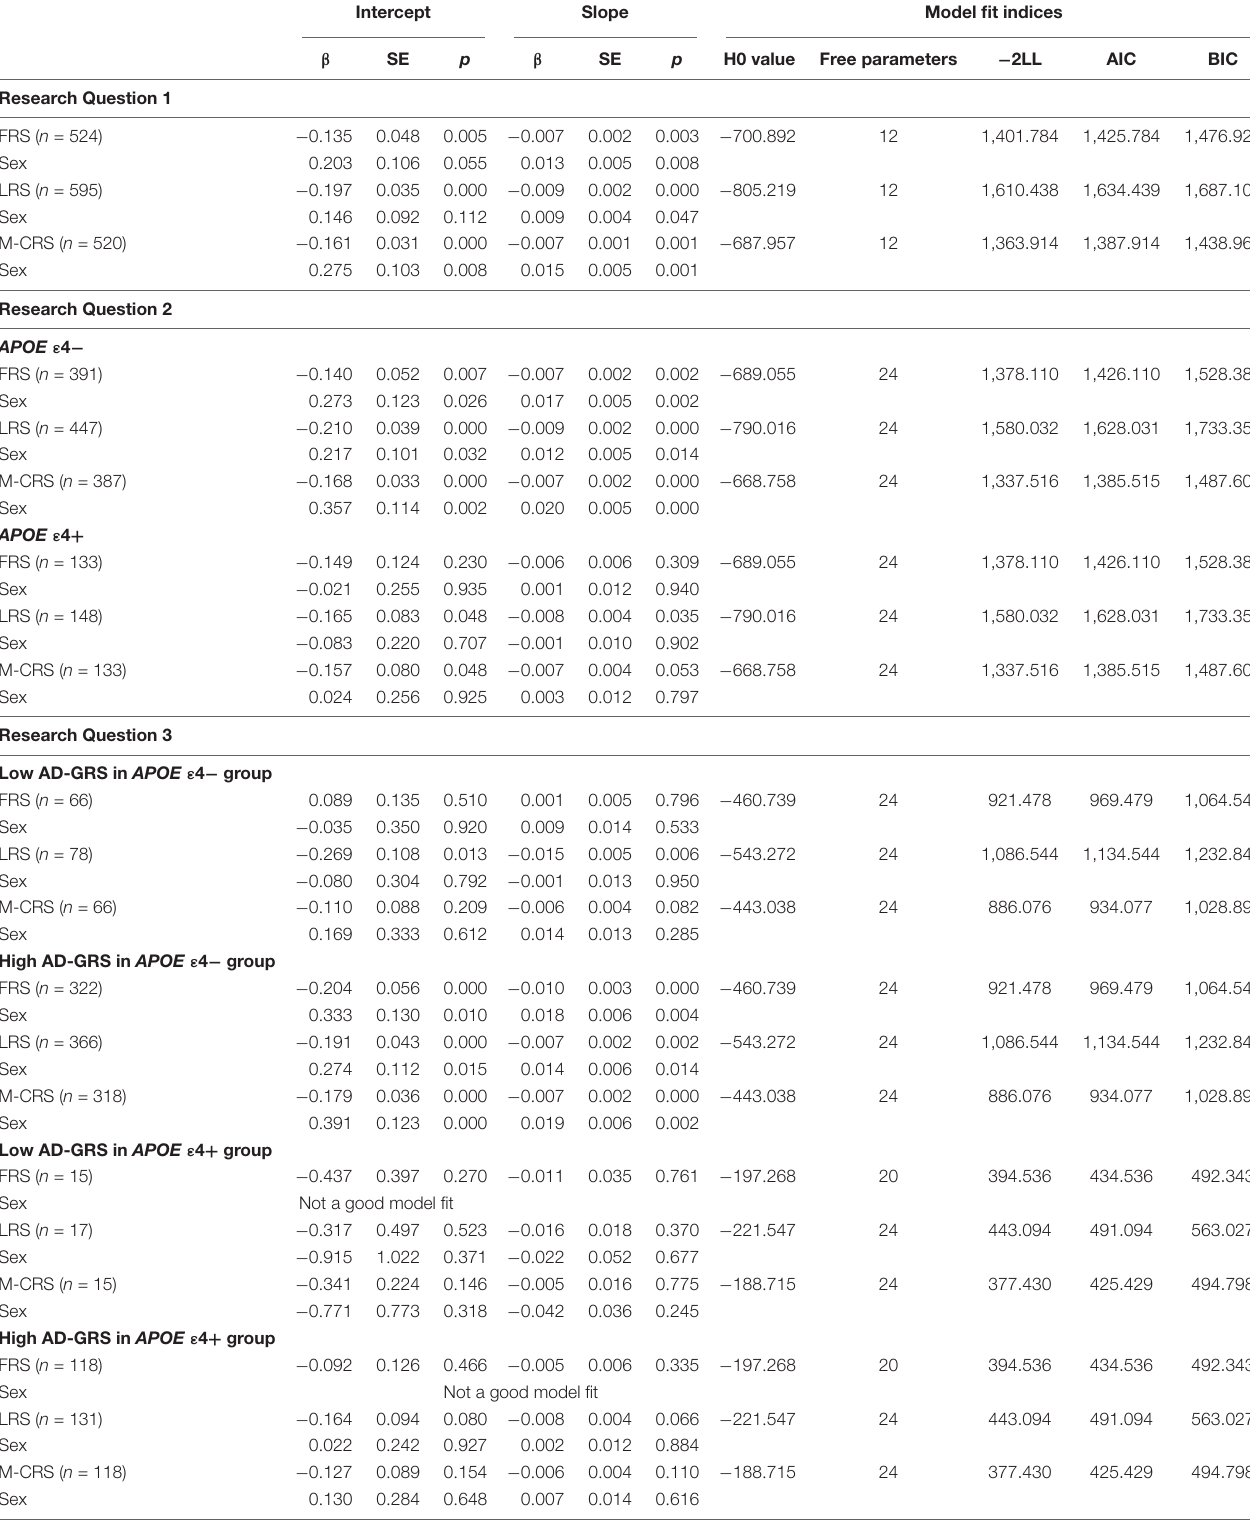
TABLE 4 | Unstandardized regression coefficients and model fit indices by research question for all models. Intercept Slope Model fit